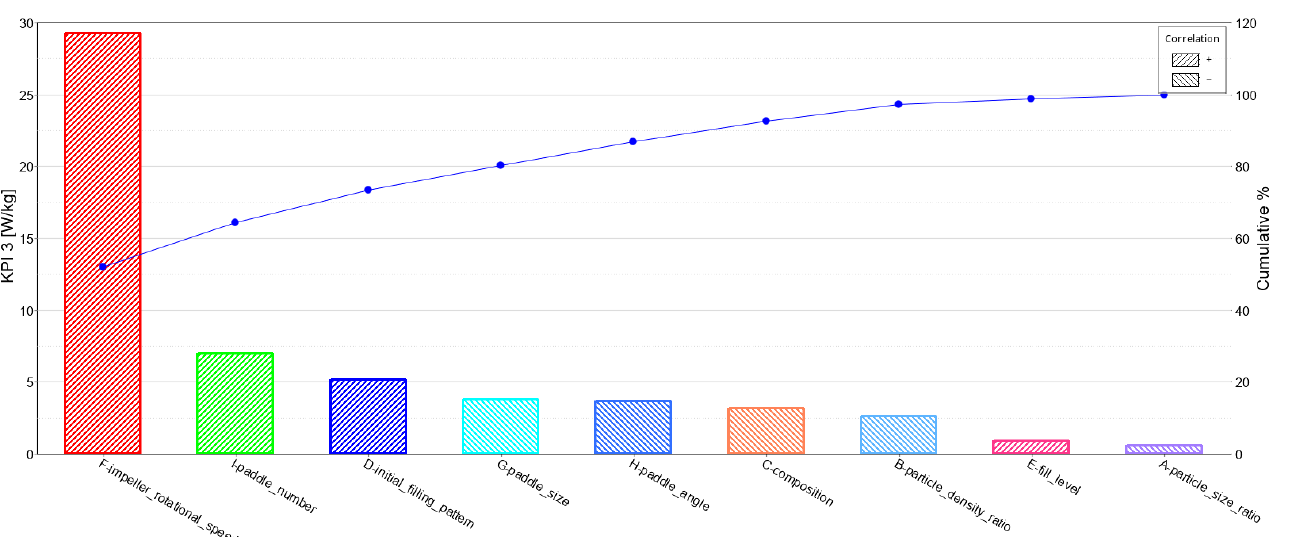
Figure 9. The main effect of factors on KPI 2 mixing time.